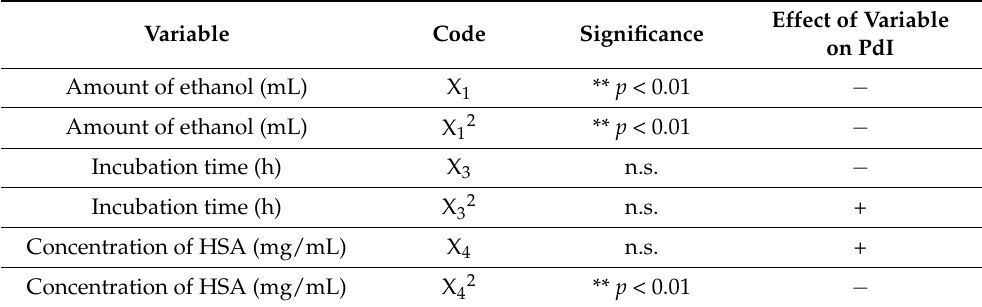
Table 10. Effect of the selected process and material parameters on the PdI of HSA nanoparticles pro- duced by the rapid coacervation method. Statistical analysis: One-way ANOVA, α = 0.05. (** p < 0.01 significant, while n.s. means non-significant effect). Variable Code Significance